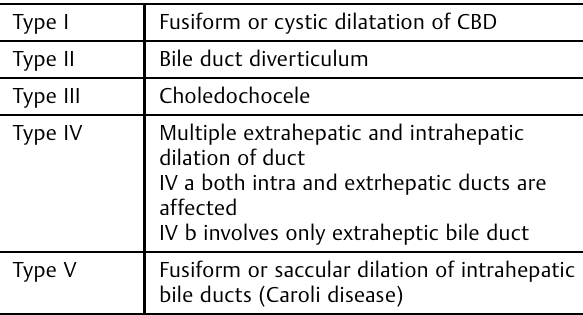
Table 1 Todani modi fi cation of Alonso-Lej classi fi cation for choledochal